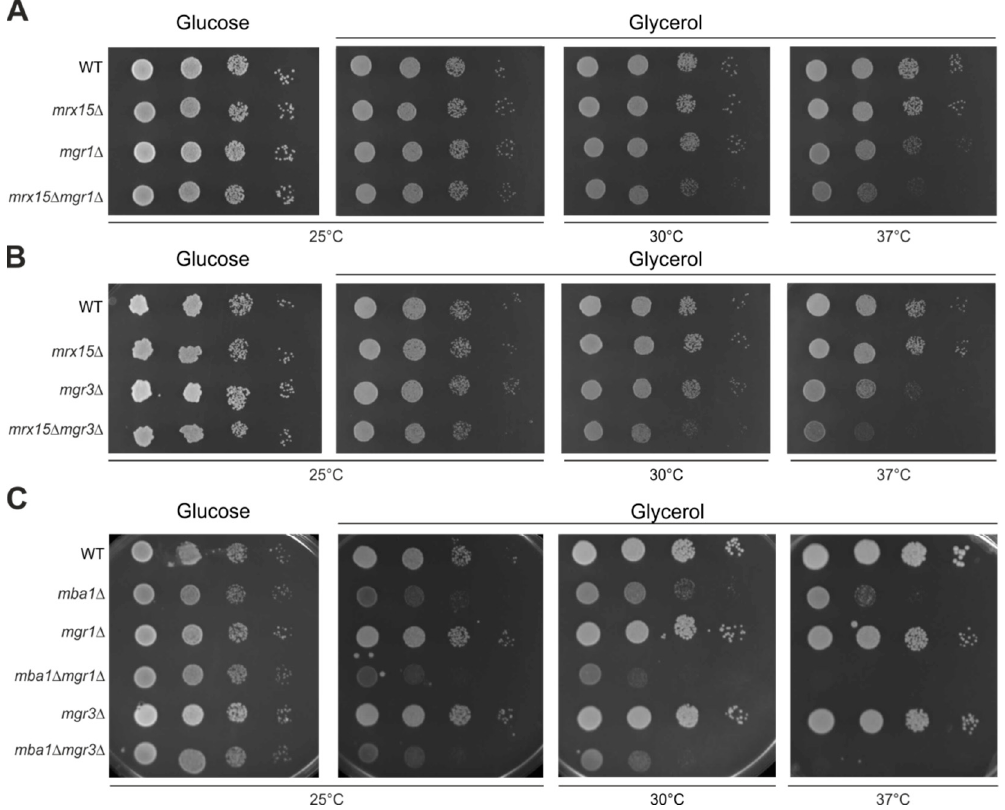
Figure 2. MRX15 and MBA1 functionally interact with MGR1 and MGR3 . ( A – C ) Serial dilution growth test on fermentable (glucose) and non-fermentable (glycerol) carbon sources of indicated strains. Cells were grown to logarithmic phase, spotted in 10-fold dilutions, and incubated at 25 °C, 30° C and 37 °C.